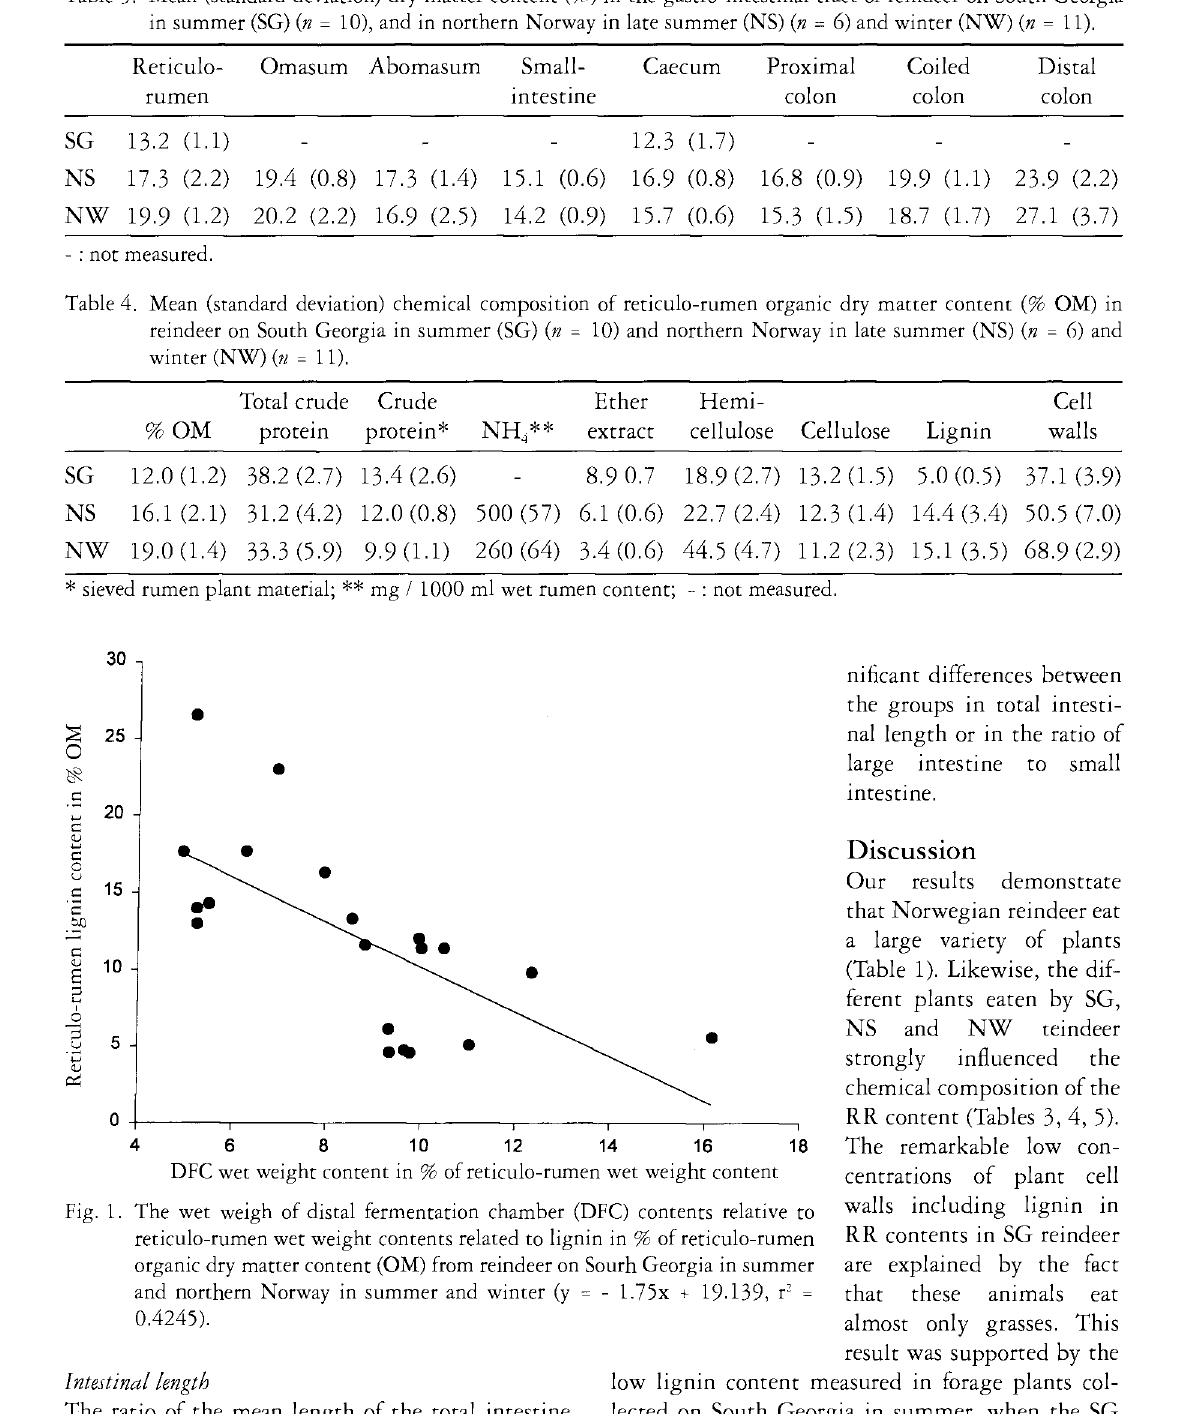
Table 3. Mean (standard deviation) dry matter content {%) in the gastro-intestinal tract of reindeer on South Georgia in summer (SG) (n = 10), and in northern Norway in late summer (NS) (n = 6) and winter (NW) (n - 11). Reticulo-